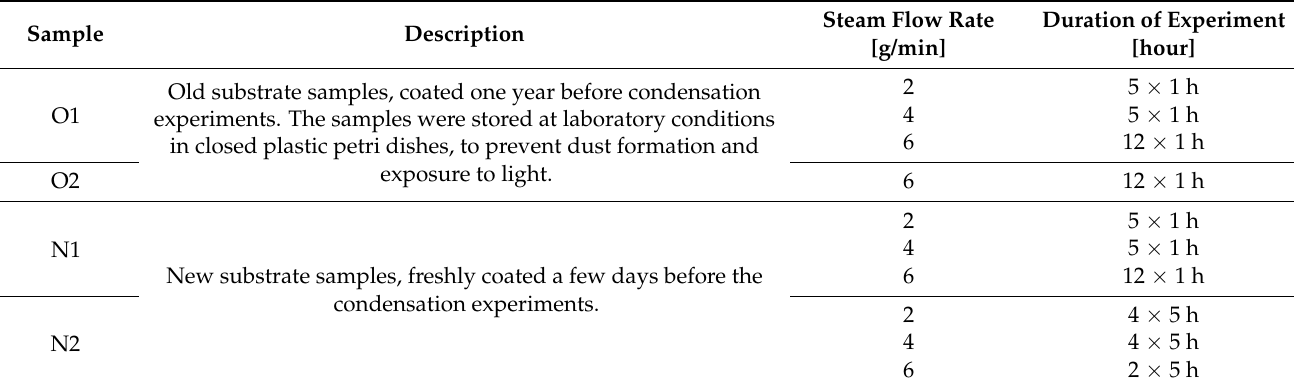
Table 1. Description of experimental samples and test